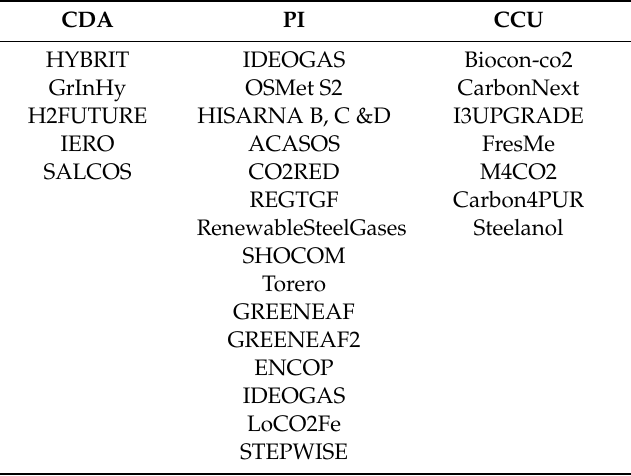
Table A3. List of acronyms of identified Projects related to the Low Carbon Future